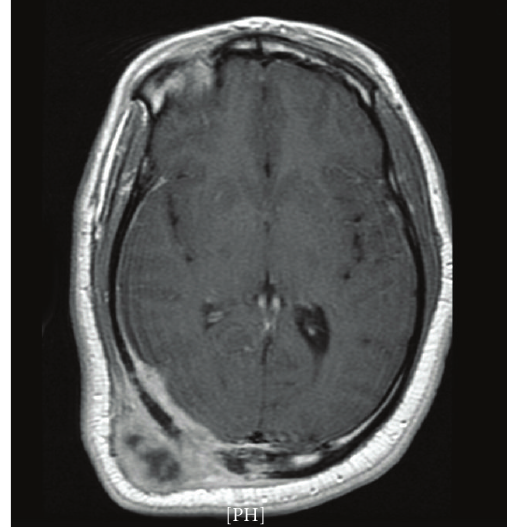
Figure 1: CT scan of the head shows a large vascular soft tissue mass involving the meninges and invasion of right parietal bone.